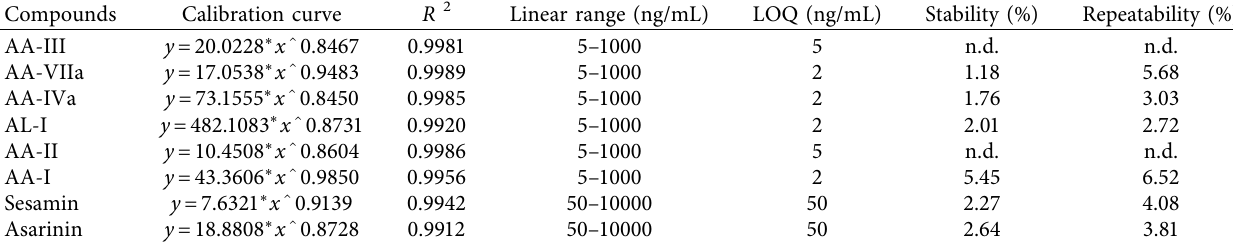
Table 3: The representative calibration curve, linear range, LOQs, stability, and repeatability of analytes ( n � 3). Compounds